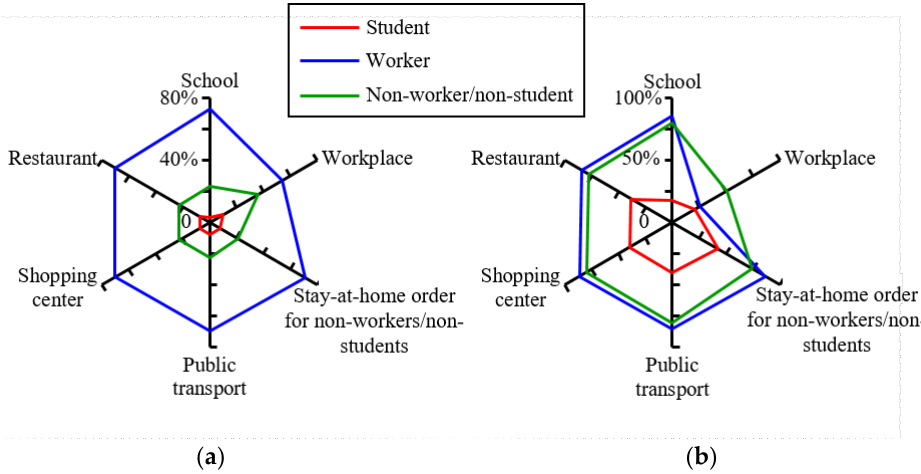
Figure 3. Infection rate under typical built environment-closure interventions (interventions were assumed to be implemented on the 31th day after the first confirmed case). ( a ) Absolute infection rate (the ratio of the total infections of students, workers, and non-workers/non-students to the total infections). ( b ) Relative infection rate (the ratio of the total infections of students, workers, and non-workers/non-students to the total number of students, workers, and non- workers/non-students,